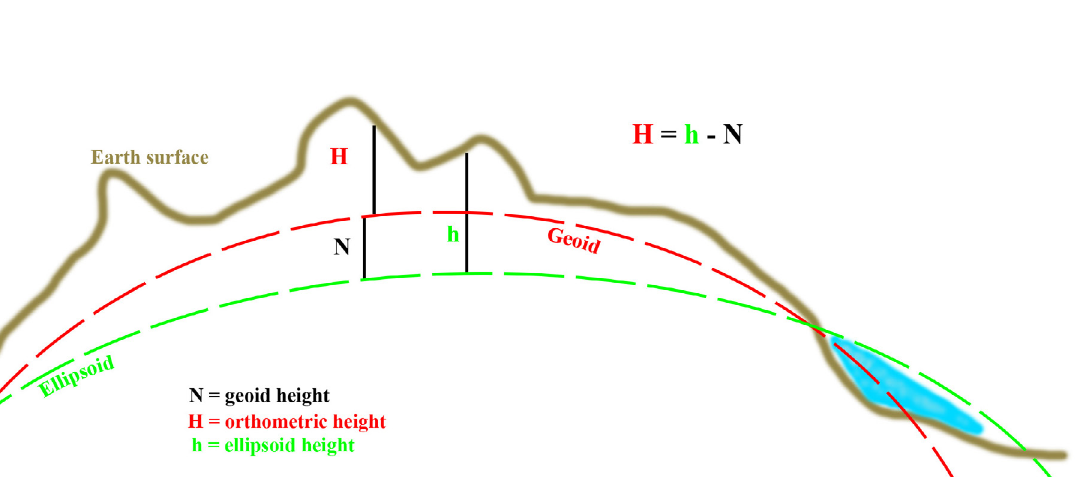
Figure 4 . The relationship between heights systems © M. Hernández